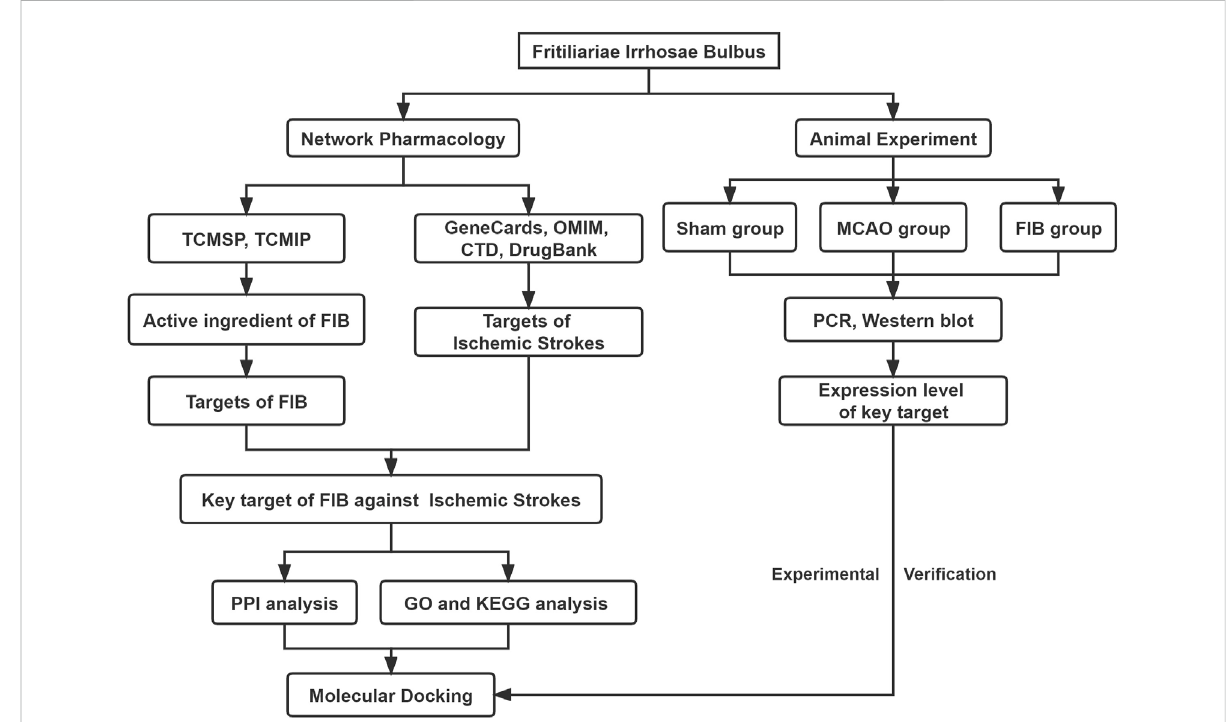
FIGURE 1 Flow chart of the network pharmacology of Fritiliariae Irrhosae Bulbus (FIB) against Ischemic